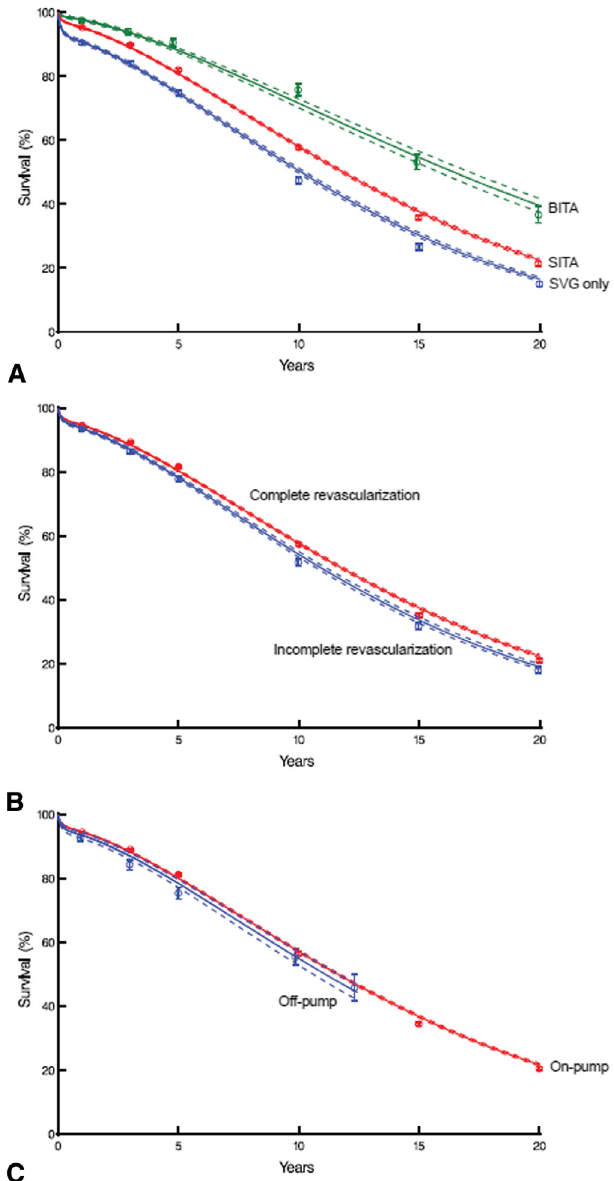
Fig. 1 – Survival curves after CABG in diabetic patients. Each symbol represents a death at 1, 3, 5, 10, 15, and 20 years after surgery as estimated by Kaplan-Meier. Vertical bars are confidence intervals with standard error of ± 1. Continuous lines are parametric estimates within intermittent lines with standard error ± 1. A: Stratification by both ITAs (BITA and SITA) isolated and only saphenous vein (SVG). B: Stratification according to complete versus incomplete revascularization. C: Stratification according to CABG with ECC (on- pump) and CABG without ECC (off-pump) [29]